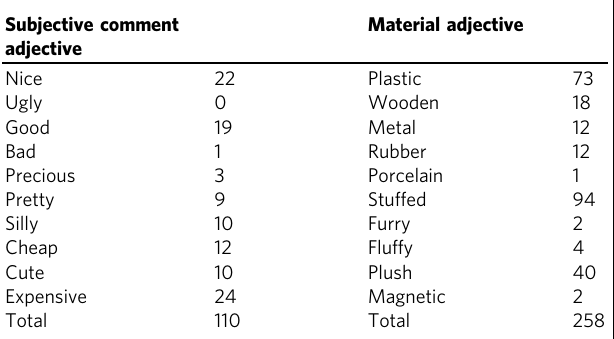
Table 2 Frequency of constructions in the categories ‘ subjective comment + toy ’ and ‘ material + toy ’ based on